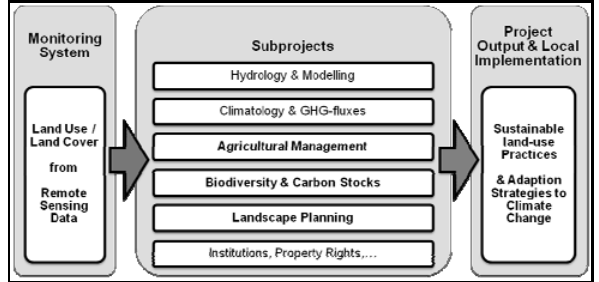
Figure 7 Acquisition of land use changes with